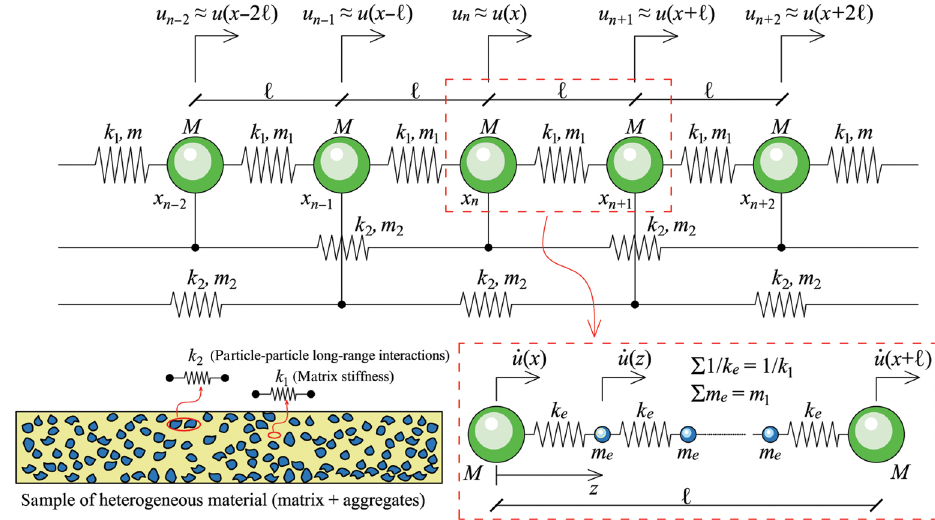
Figure 1: Non-local lattice model with two neighbor interactions and physical counterpart.